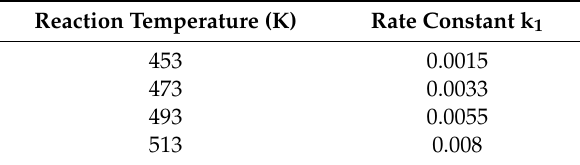
Figure 2. Plots of −ln (1−XCO 2 /XCO 2 e) versus reaction time at variant reaction temperatures. The magnitudes of k 1 , obtained from slope are documented in Table 1. Table 1. Rate constants at different reaction temperature.